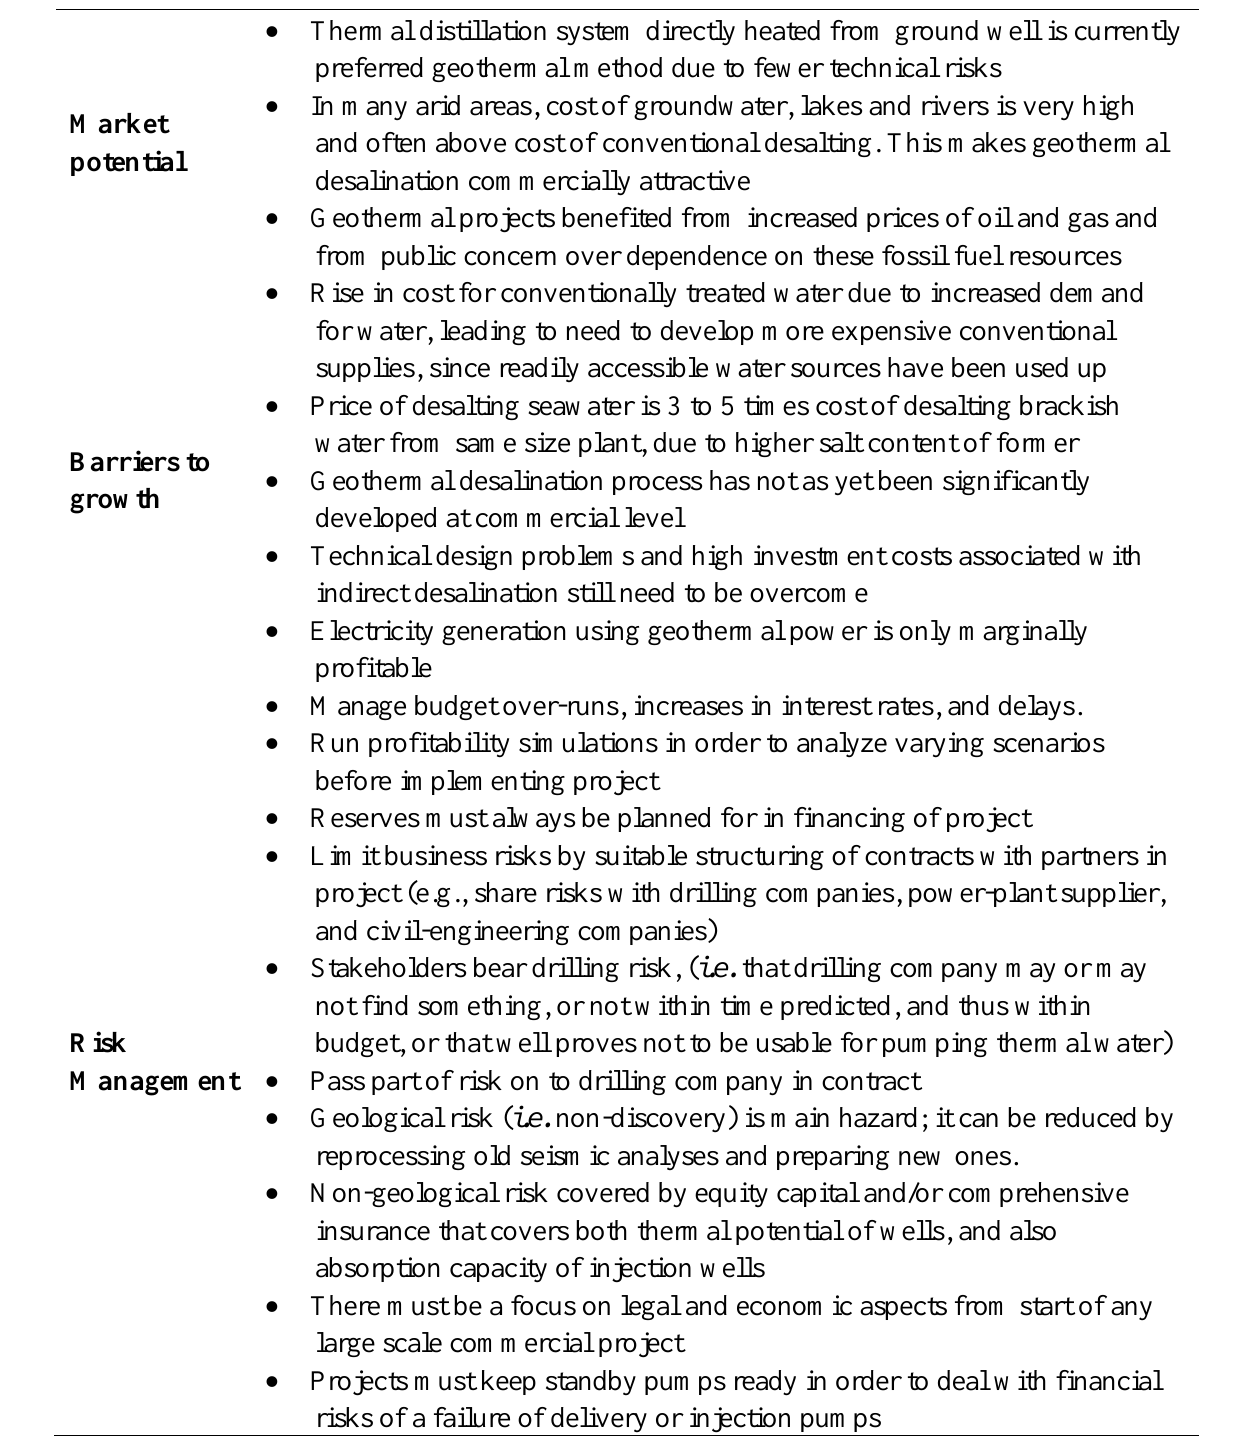
Table 3. Summary of market potential, barriers to growth and risk management of geothermal